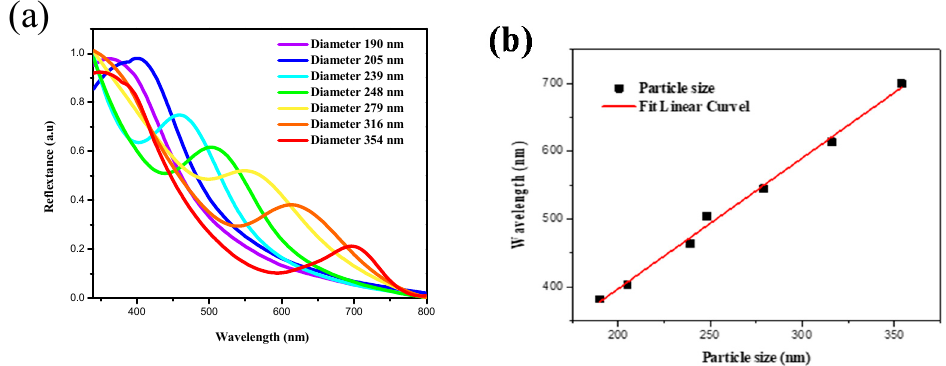
Figure 7. ( a ) Reflectance spectra of PC films consisting of SiO 2 spheres with particle dimensions between 190 and 354 nm; and ( b ) linear regression plot of photonic band gap (PBG) wavelength versus particle size.